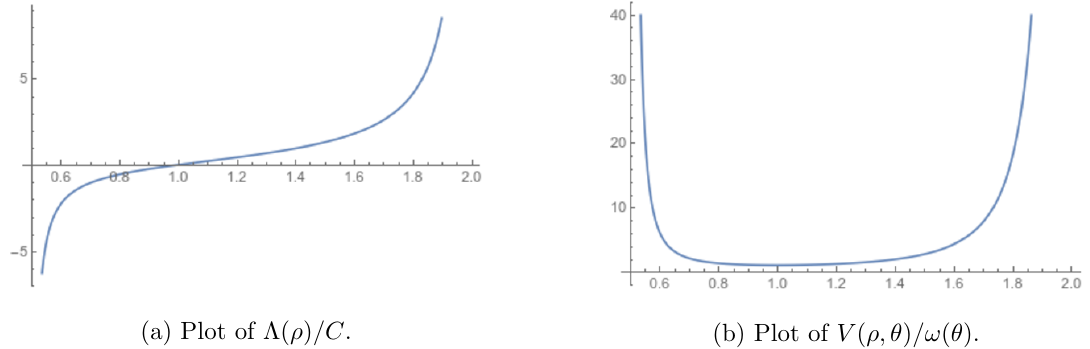
(a) Plot of (cid:3)( (cid:26) ) =C . (b) Plot of V ( (cid:26); (cid:18) ) =! ( (cid:18) ). Figure 13. Plot of the radial pro(cid:12)les of (cid:3) =C and V on the hyperbolic annulus of modulus (cid:22) = 2 log 2 (i.e. for R = 2). In this case (cid:26) runs from 1 = 2 to